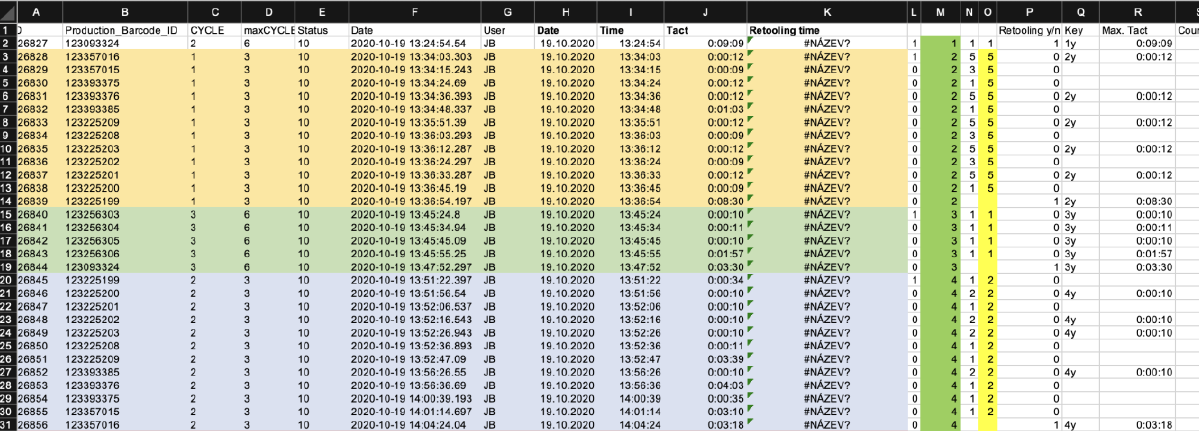
Figure 4. An example of the machine data sorted by the column “CYCLE”.